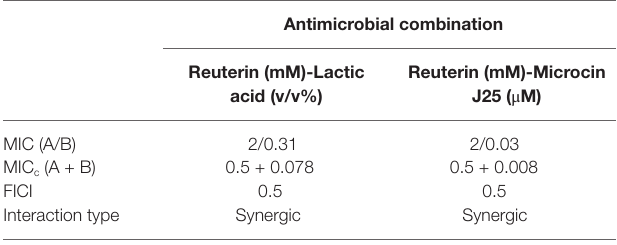
TABLE 1 | Inhibitory concentrations of the compounds against Salmonella Enteritidis. Antimicrobial